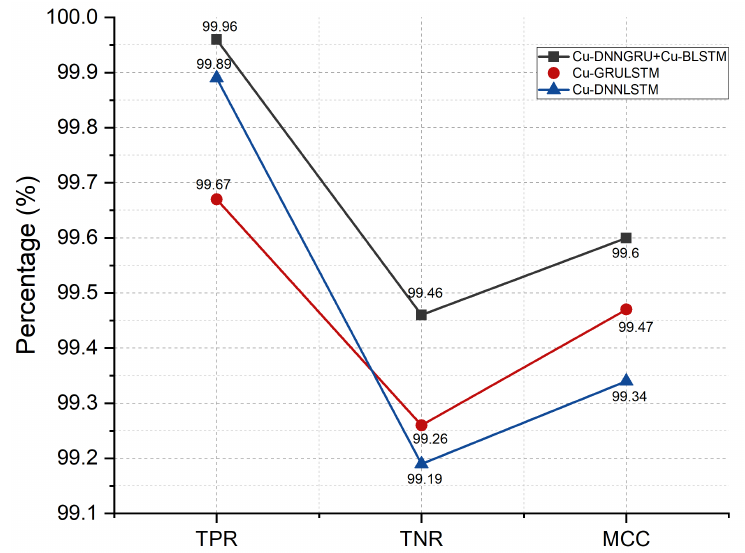
Figure 7. TNR, TPR, and